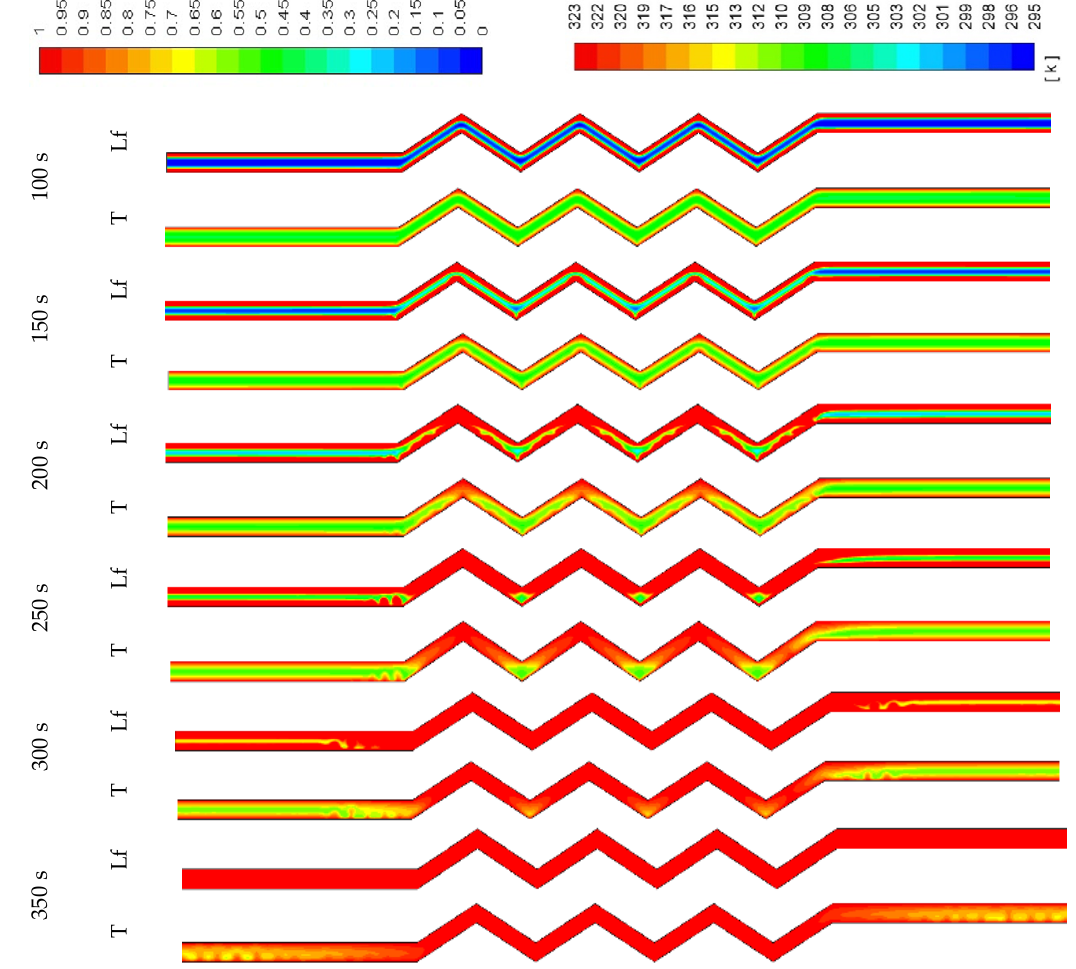
Figure 9. Contours of the liquid-fraction and temperature during the melting process in the horizontal corrugated channel for the standard width (0.9 cm).